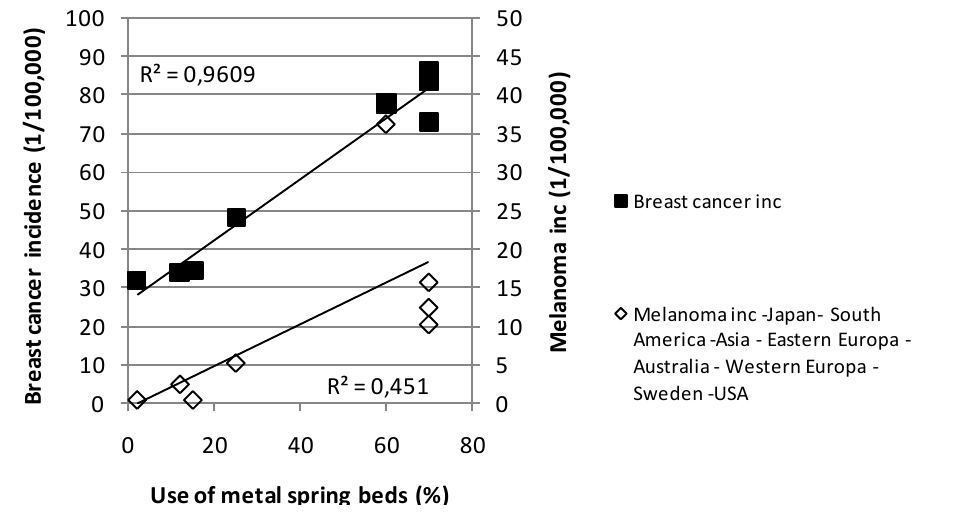
Figure 16. Melanoma and breast cancer incidence vs . the use of metal spring beds in different parts of the world, from [11].